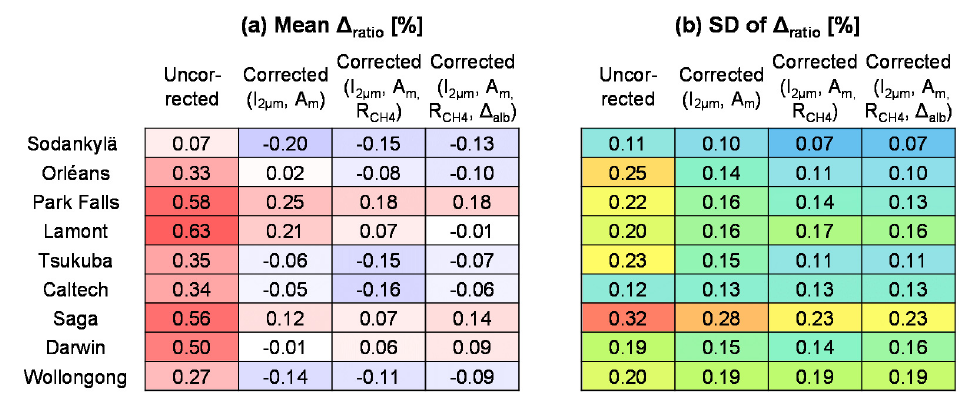
Figure 10. Temporal variation of the relative difference in the ratio component between GOSAT (bias-uncorrected and bias-corrected) and TCCON ( ∆ ratio ) for each TCCON site: ( a ) Sodankylä; ( b ) Orléans; ( c ) Park Falls; ( d ) Lamont; ( e ) Tsukuba; ( f ) Caltech; ( g ) Saga; ( h ) Darwin; ( i ) Wollongong. Individual data and monthly mean are plotted. Results for the data acquired in the odd-numbered years are shown to assess the applicability of the bias correction using the independent data (coefficients for the correction were obtained using the data acquired in the even-numbered years).